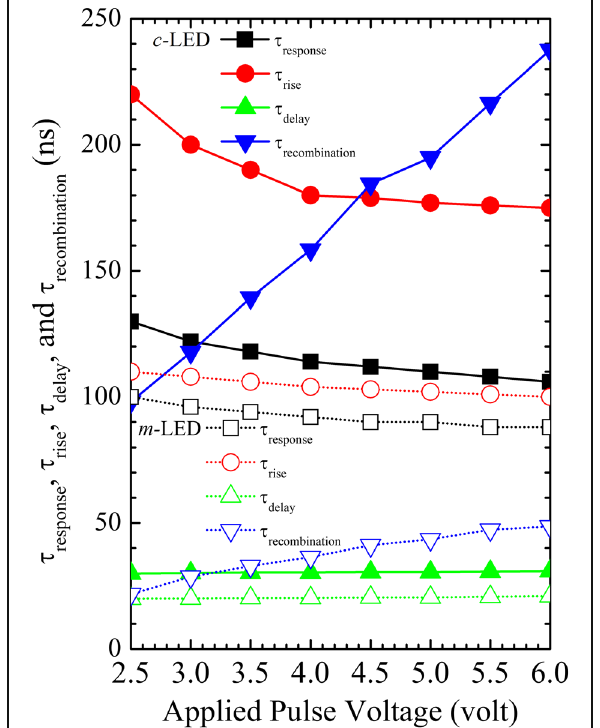
Fig. 5 Response ( τ response ), rise ( τ rise ), delay ( τ delay ), and recombination ( τ recombination ) times as functions of applied pulse voltage for the two